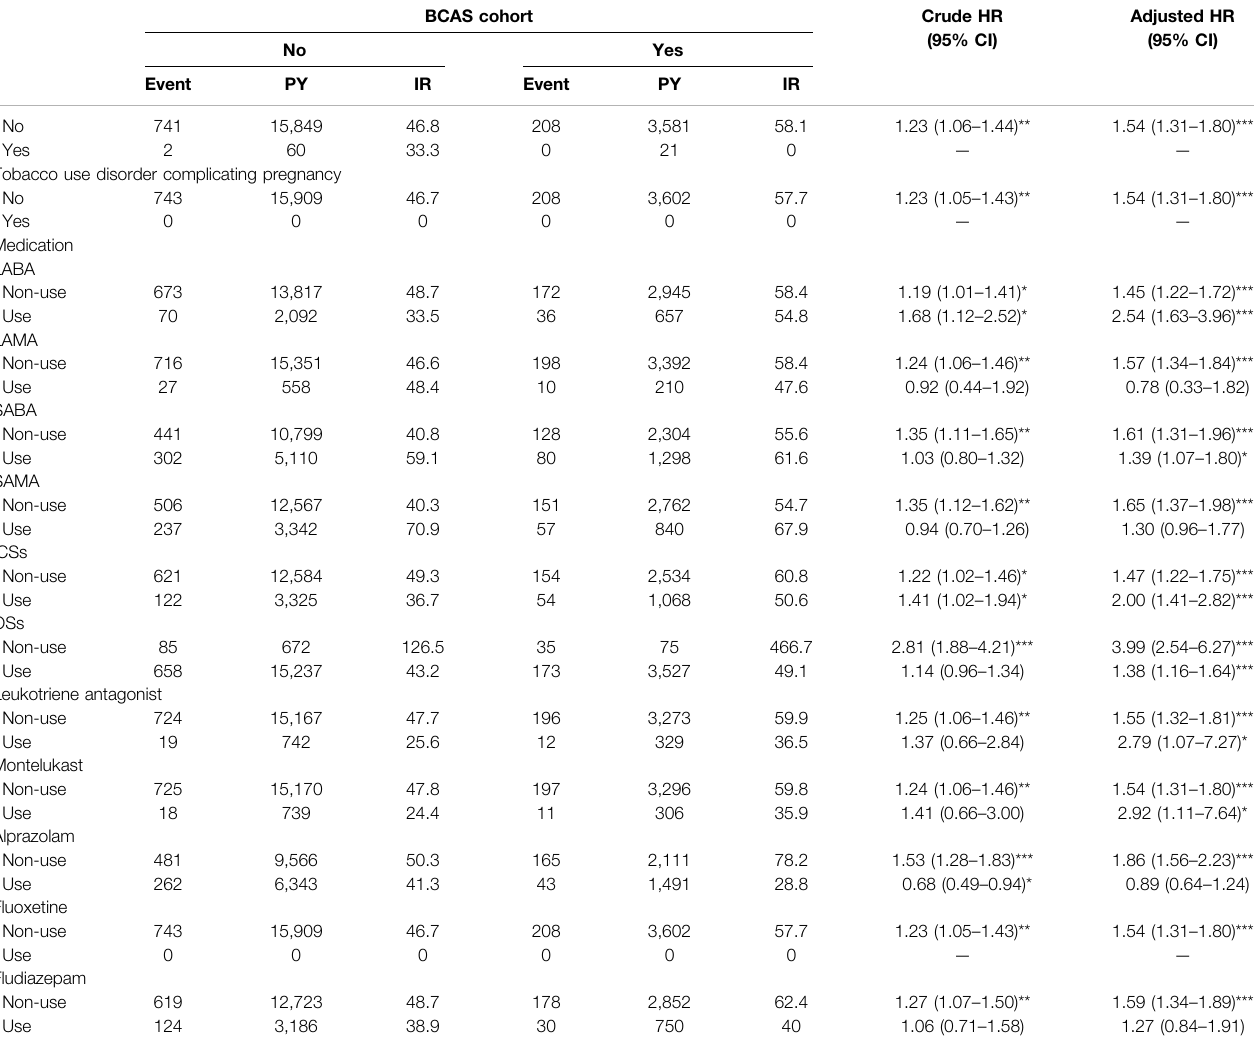
( Table 4 ). A Kaplan – Meier analysis revealed statistically pneumonia between the BCAS and non-BCAS cohorts (log rank test: p = 0.008) ( Figure 1 ). The area under curve for BCAS applied to predict PTB or pneumonia occurrence was 0.7195 (95% CI